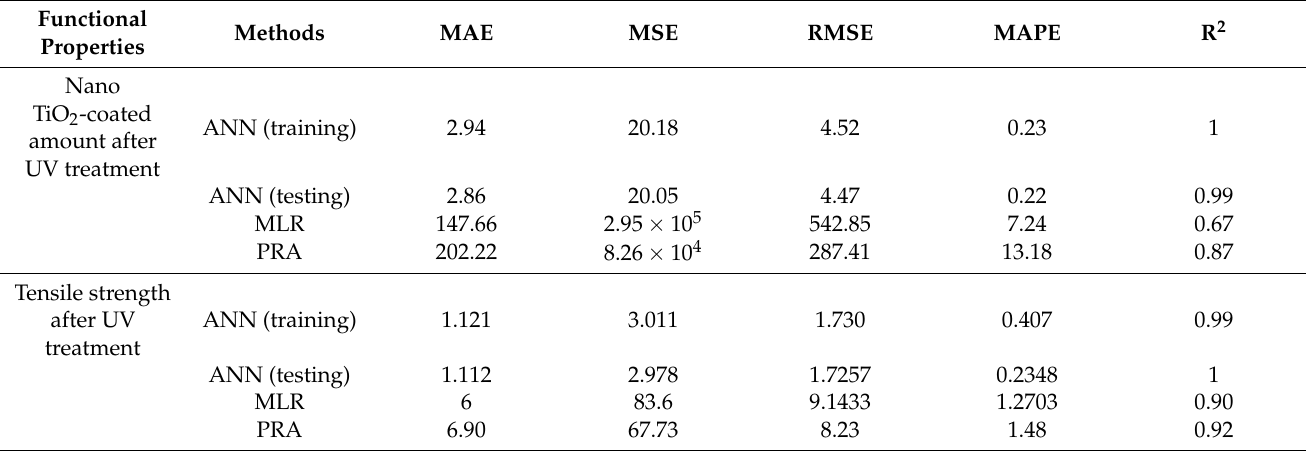
Table 3. Errors of ANN, MLR and